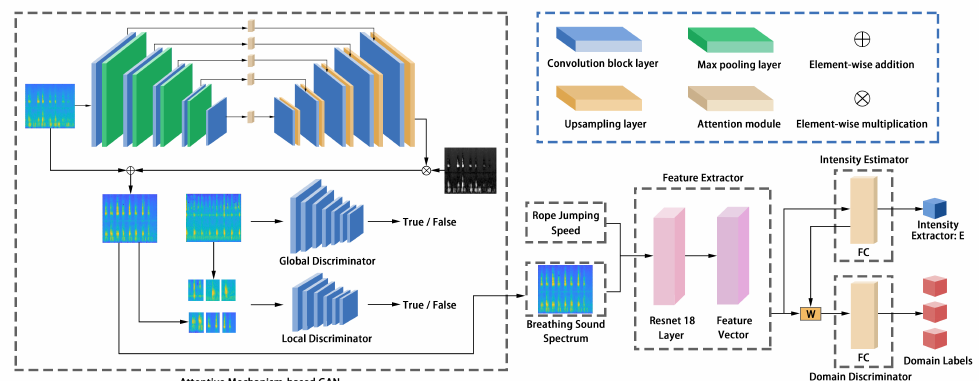
Figure 8. Network